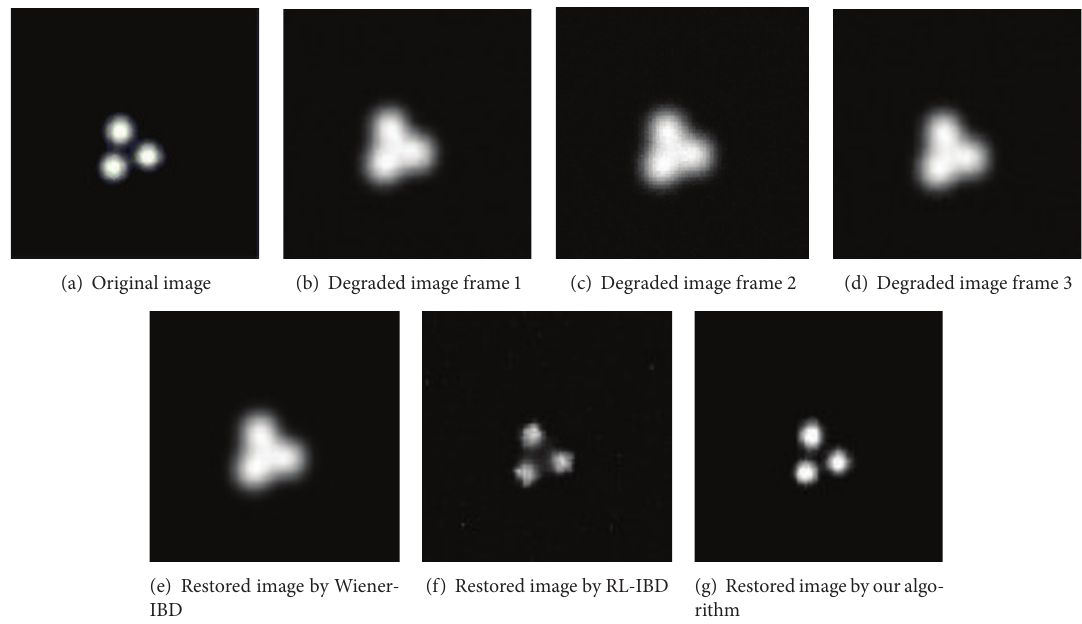
Figure 2: Degraded images in experiment and restoration comparison of three algorithms.